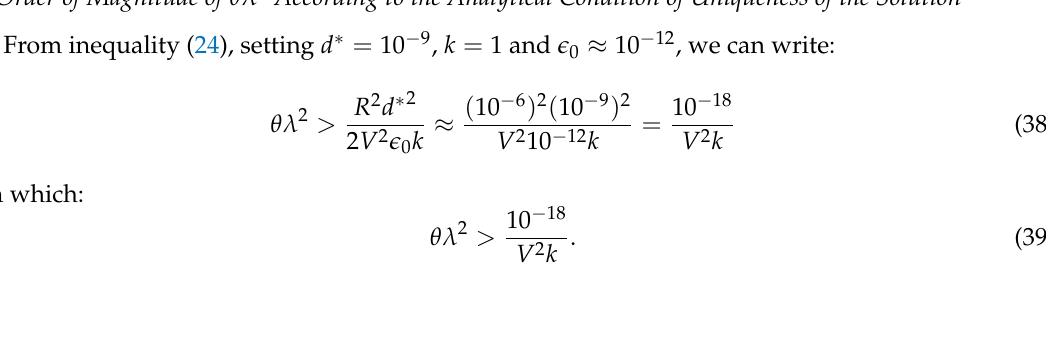
Figure 5. Recovering of the membrane by using the bvp4c MatLab R (cid:13) solver: θλ 2 = 0.5, 9.475 ≤ u 1 ≤ 9.62, 12.71 ≤ u 1 ≤ 15 and u 1 ≥ 19.979, u 2 = 0. 8.2. Order of Magnitude of θλ 2 According to the Analytical Condition of Uniqueness of the